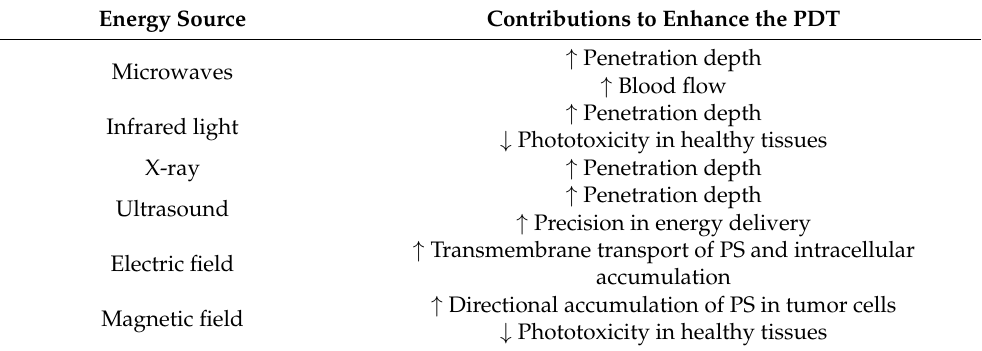
Table 3. Summary of the contribution of different energy sources in overcoming the limitations of PDT.